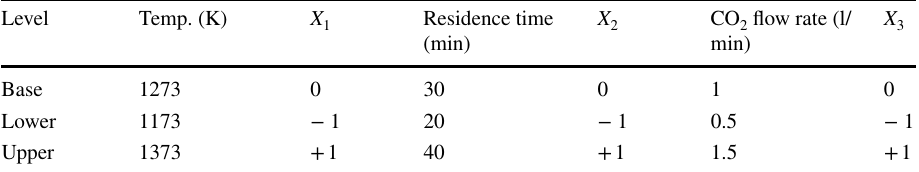
Table 6 Parameters range and their